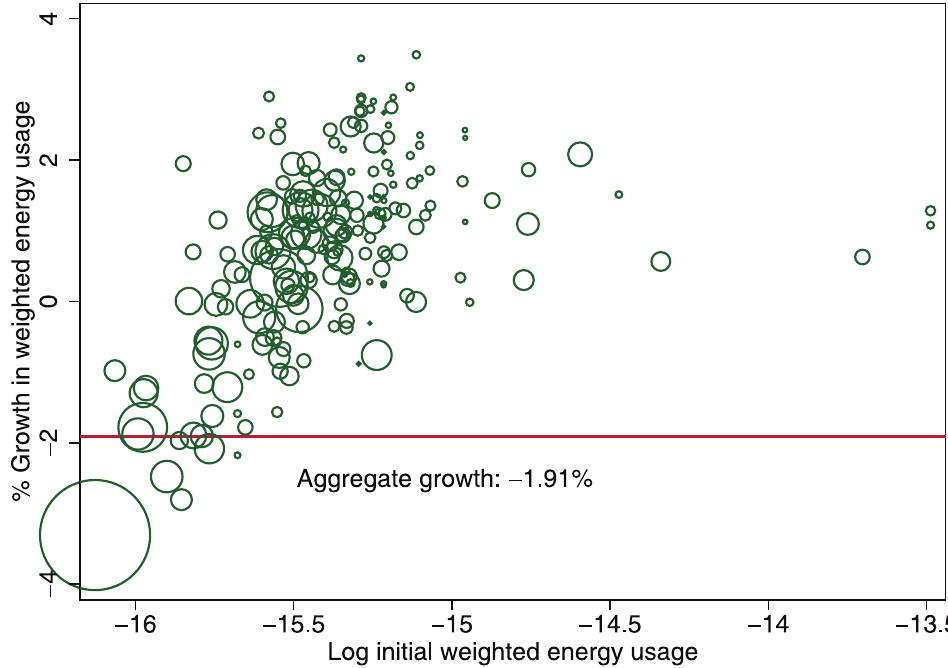
Fig 9. Energy gain due to taxation change ( τ = 0.2 ! τ = 0). Taxation of labor income is changed from being progressive to flat with respect to a city’s cost of living.